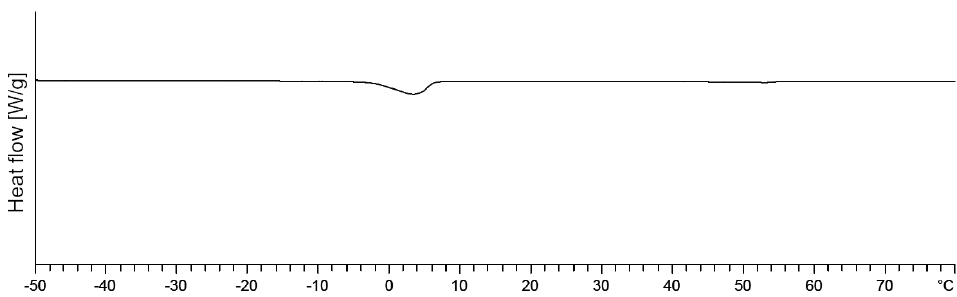
Figure 9. DSC thermogram of a mixed crystal containing 1,2-hexanediol, standard concentration.